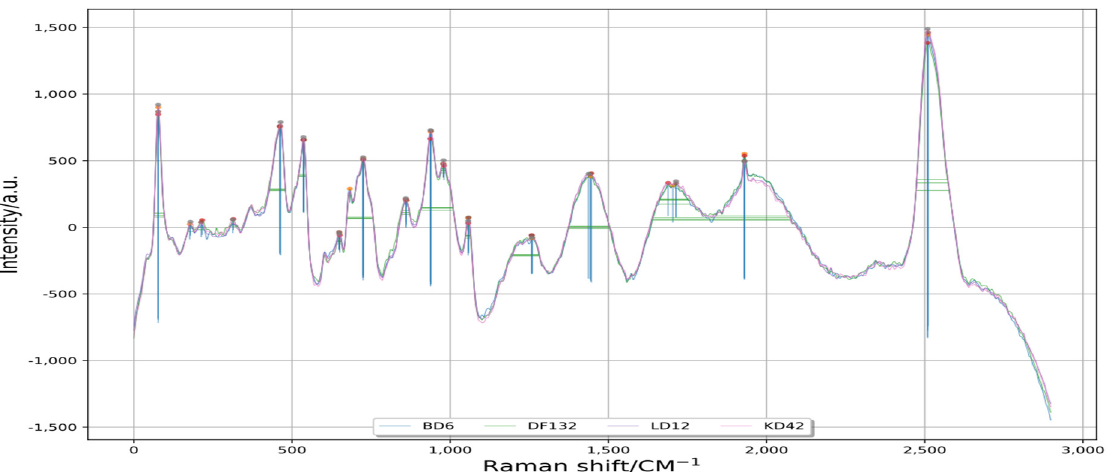
Figure 5. Crest and its four-dimensional feature information. Prominence is the length of the blue vertical line, width is the width of the green horizontal line, width_height is the length from the green line to the peak, and peak_dif is the peak offset. Raman shift is the reciprocal of wavelength, unrelated to the frequency of incident light and only related to the vibration frequency of sample molecules, and its range is 200–3400 cm − 1 . Intensity is the intensity of Raman scattering, which is the anti-Stokes line; the anti-Stokes line is the scattering light of frequency shifted light from monochromatic incident light in a molecule.